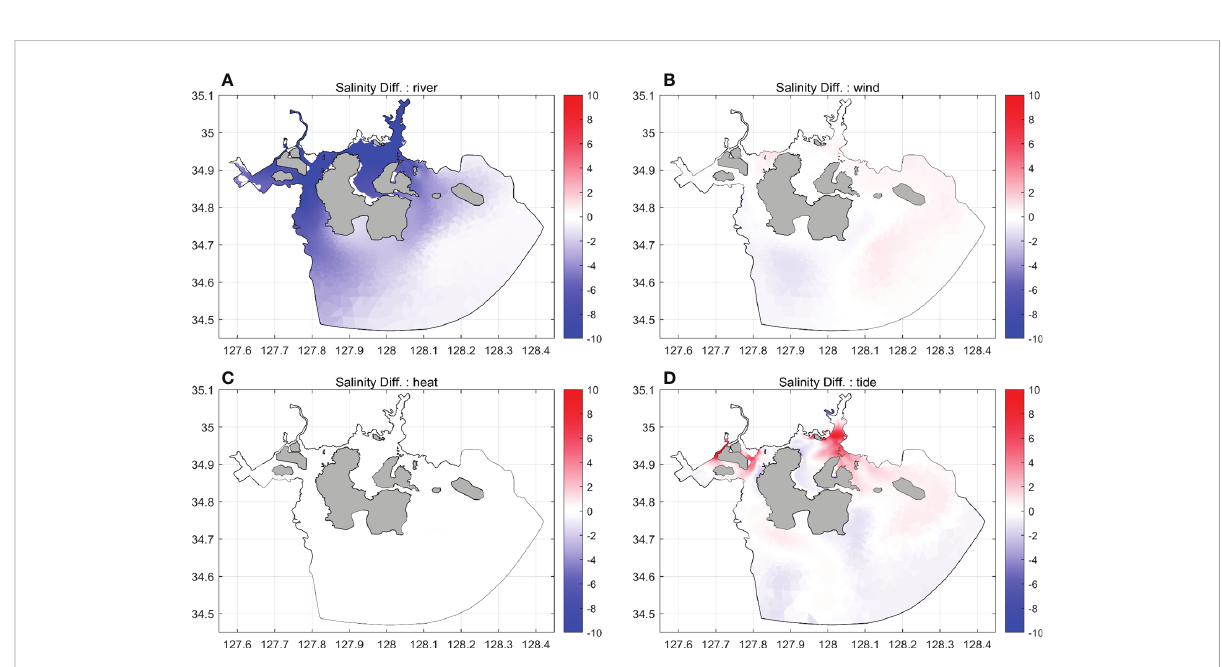
FIGURE 6 Same as Figure 5, but with surface